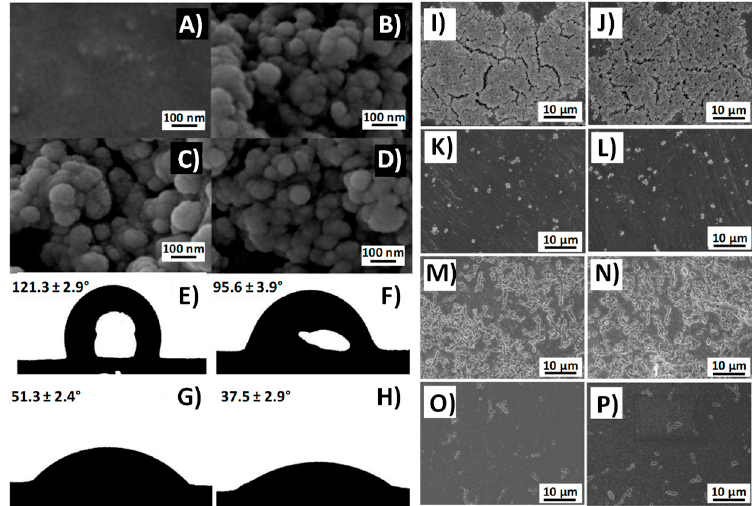
Figure 8. Scanning electron microscopy (SEM) images of ( A ) Silicone film (Si), ( B ) MSNPs coated Si (MSNPs-Si), ( C ) Agarose-incorporated MSNPs-Si (AMSNPs-Si), and ( D ) Heparin-loaded AMSNPs-Si, respectively (HAMSNPs-Si). The static water contact angle of ( E ) Si, ( F ) MSNPs-Si, ( G ) AMSNPs-Si, and ( H ) AHMSNPs-Si. SEM images of ( I-L ) S. aureus and ( M–P ) E. coli cultured on ( I and M ) Si, ( J and N ) MSNPs-Si, ( K and O ) AMSNPs-Si, and ( L and P ) AHMSNPs-Si, respectively (adapted with permission from [161], copyright American Chemical Society 2017).